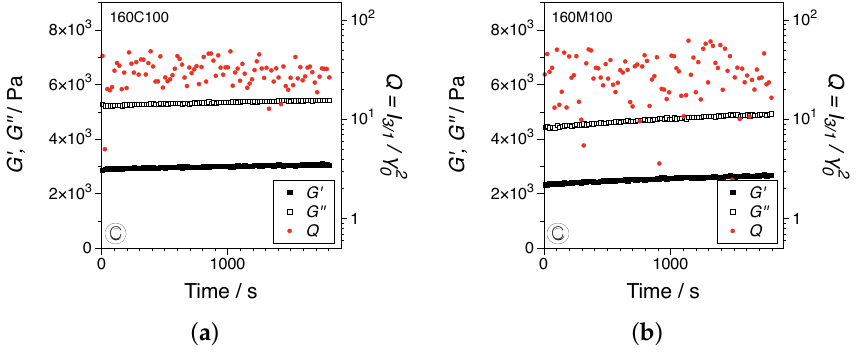
Figure 8. Transient development of the dynamic moduli and the Q -parameter in SAOS, γ = 1% and ω = 0.5 rad/s: ( a ) 160C100 and ( b ) 160M100. All measurements were performed at 160 ◦